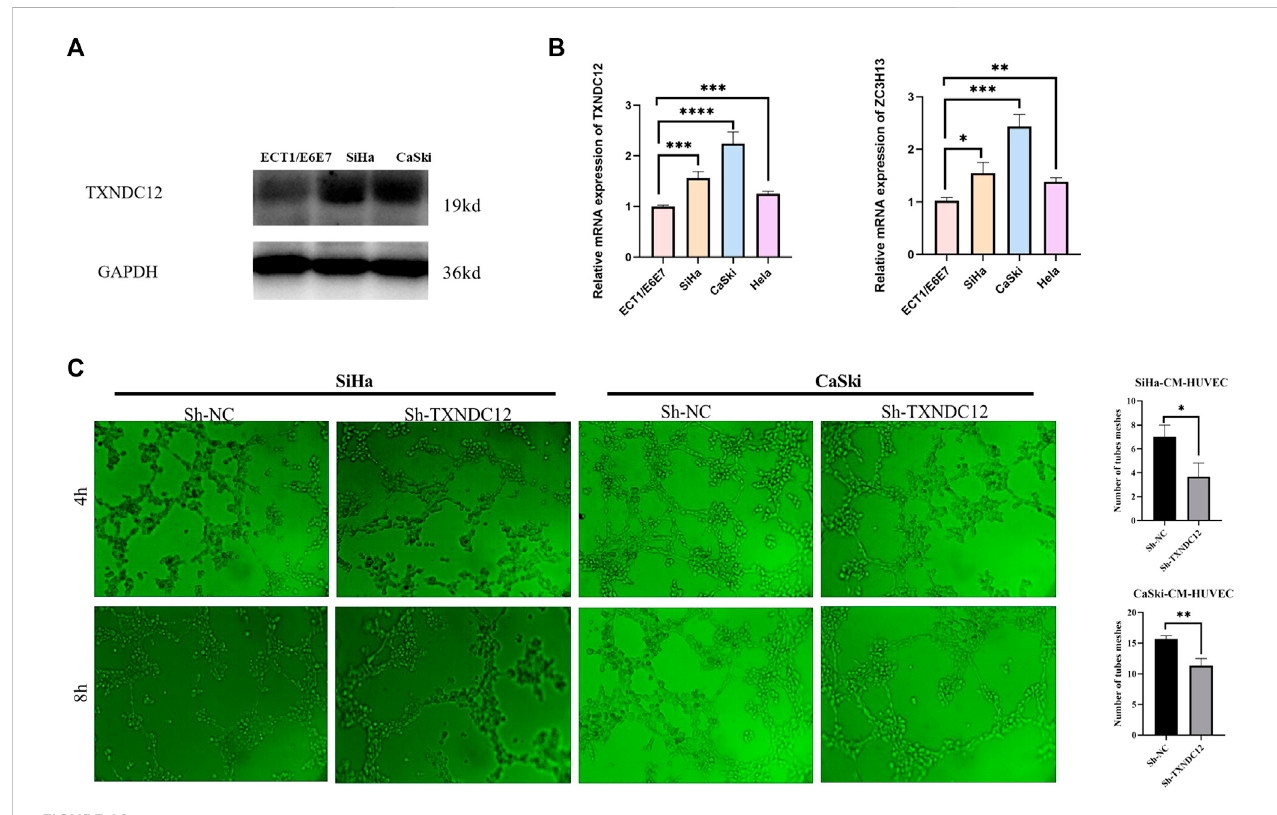
FIGURE 10 TXNDC12 expression and tubule formation assay. (A,B) Western blotting and qPCR to verify the expression of TXNDC12. (C) . Tubule formation assay of endothelial cells. (* < 0.05, ** < 0.01, *** <